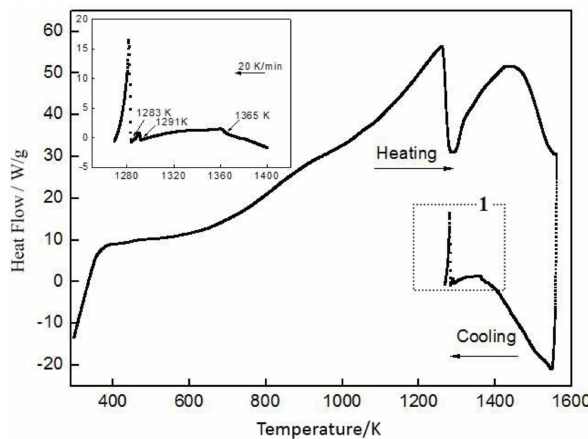
Figure 6. DSC curve of melted Cu-10Sn-2Zn-1.5Fe-0.5Co alloy at cooling rate of 20 K/min, with the upper-left enlarged image of area 1. [64]. The exothermic phenomenon during the cooling process was recorded and details can be seen clearly in the upper-left